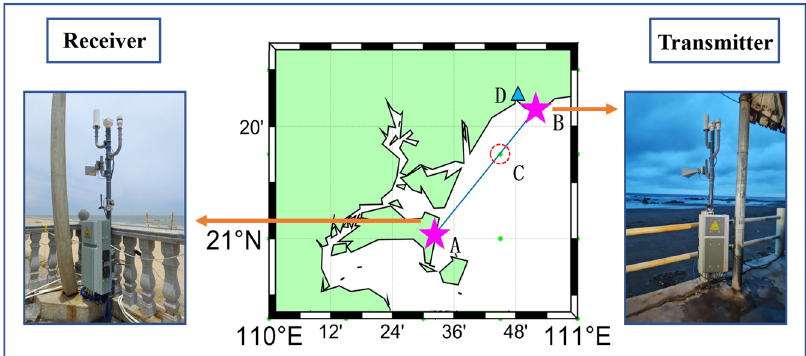
Figure 6. The propagation path and equipment used in the EM-wave propagation experiment. The green dots represent the grid points of the ERA5 data. Table 2. Data sources and coordinates.